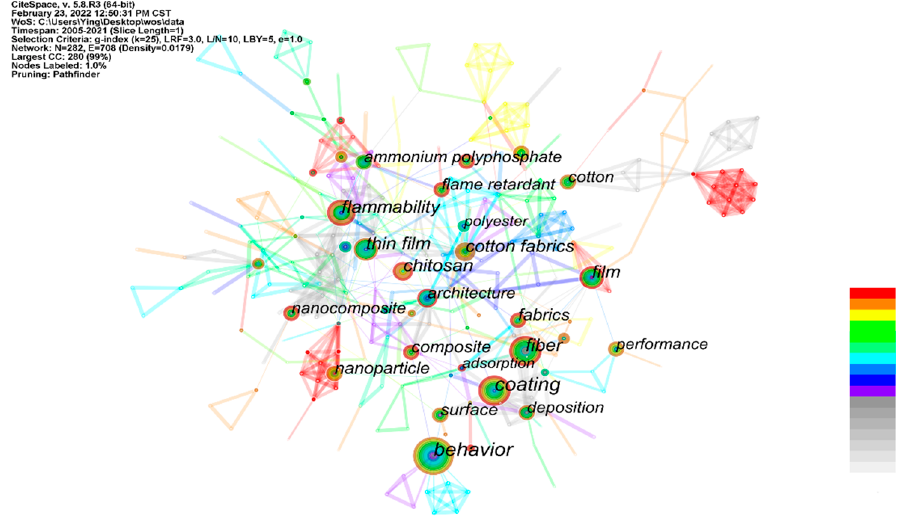
Figure 2. Knowledge mapping of the keyword co-occurrence network of the LbL self-assembly coating on fabric.